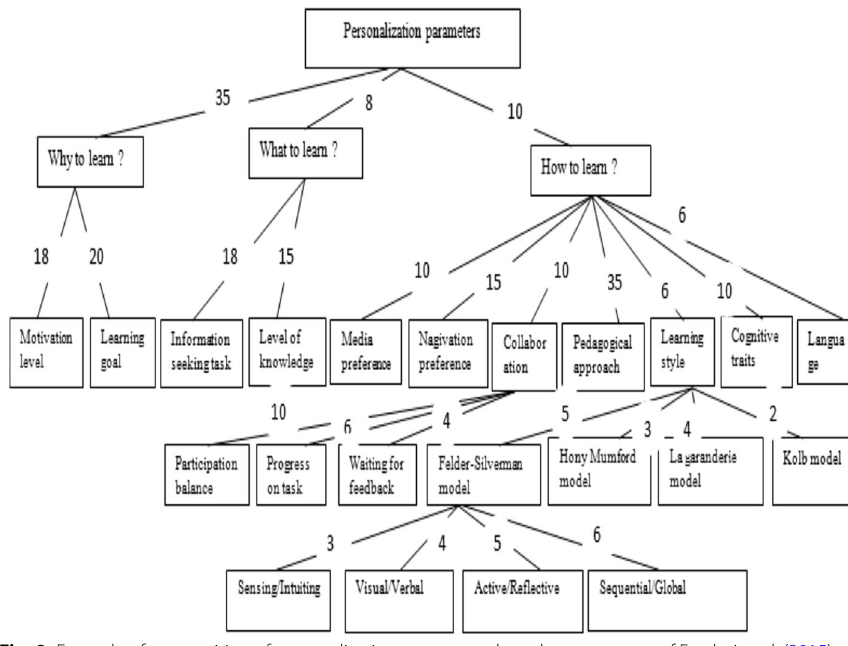
Fig. 8 Example of composition of personalization parameters based on taxonomy of Essalmi et al. (2015)